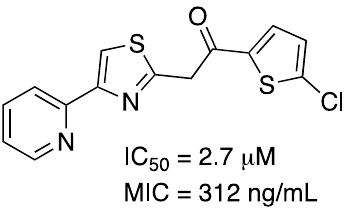
Figure 7. Structure of IMB-T130, a Mt DHQS inhibitor.